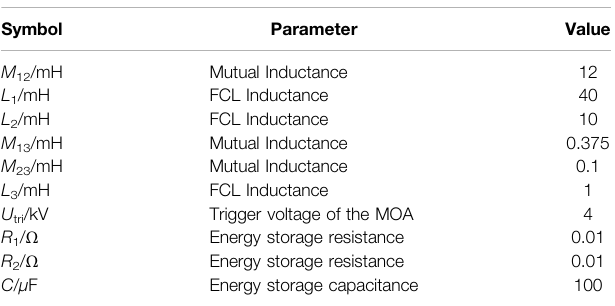
TABLE 1 | Main parameters of the